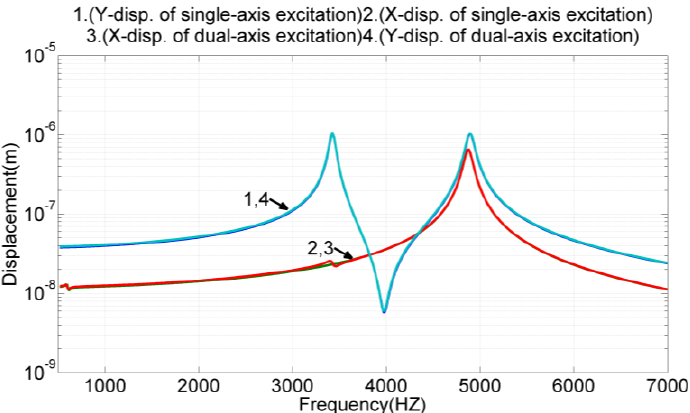
Figure 10. The proof mass displacement under x-axis and y-axis actuations, simultaneously or individually.